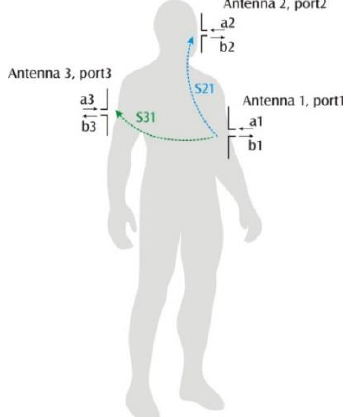
Figure 2. Scattering matrix parameters definition: S 21 = b 2 / a 1 | a 2 = 0 and a 3 = 0 S 31 = b 3 / a 1 | a 2 = 0 and a 3 = 0 .